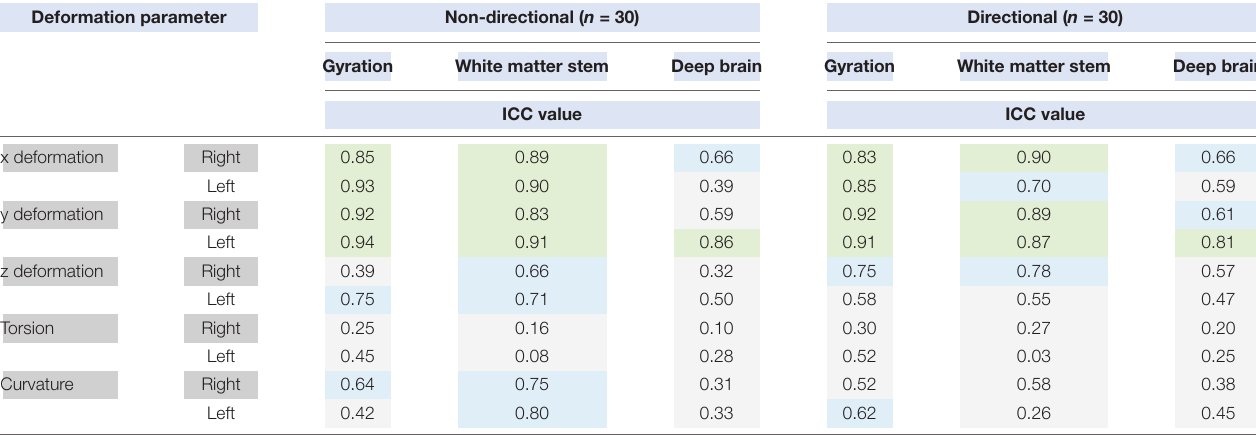
TABLE 2 | Intraclass coefficient (ICC) values (high, green; moderate, blue; gray, low; see text for details) of the deformation parameters according to the type of electrode (non-directional, directional) and the hemisphere (right, left). Deformation